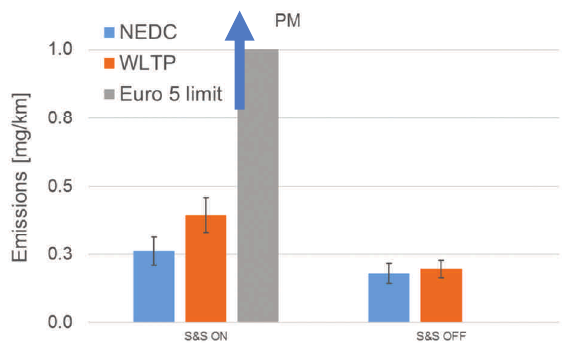
Fig. 5. PM emissions from vehicle 2. Note that the Euro 5 limit (4.5 mg/km) significantly exceeds the y-axis of the figure, being roughly ~10- ~20 times the magnitude of the measured PM emissions